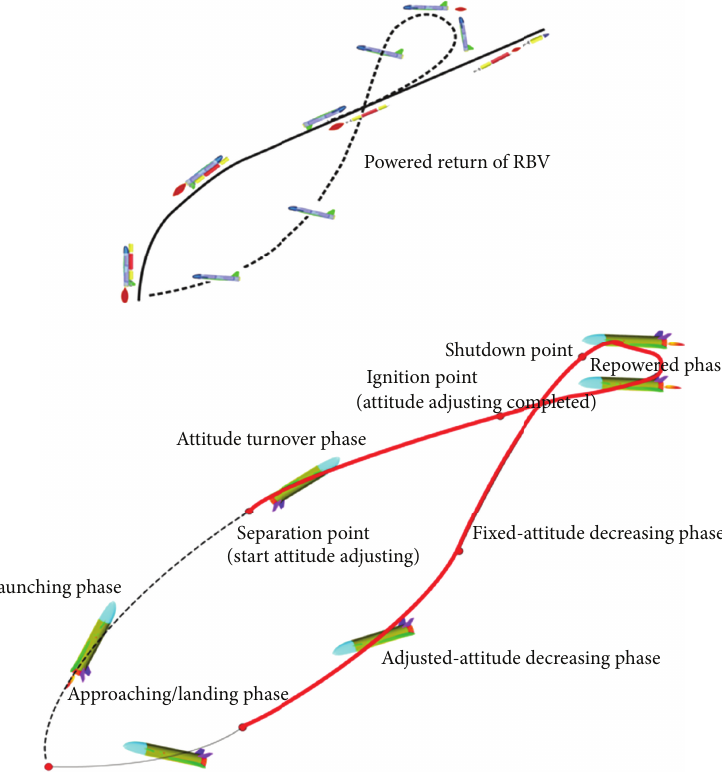
Figure 1: Flight profile of